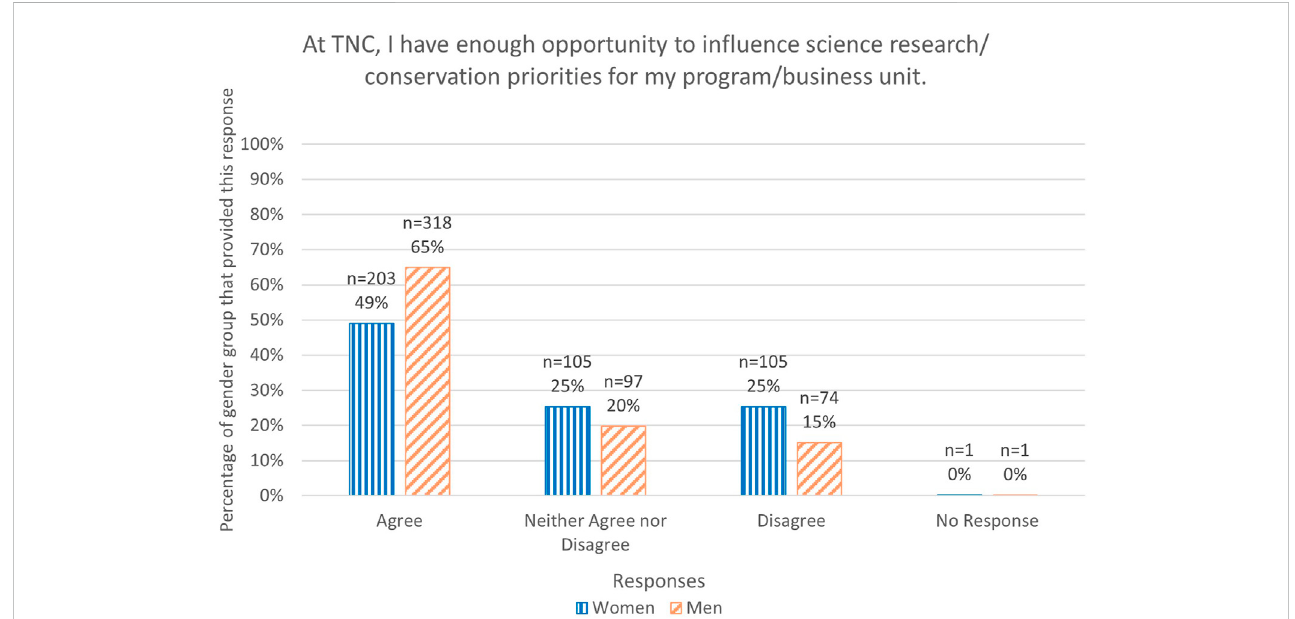
FIGURE 1 GraphofresponsestoQ7.AtTNCIhaveenoughopportunitytoin fl uenceconservationandscienceprioritiesformyprogramasapercentageofthetotal number of respondents for each gender.